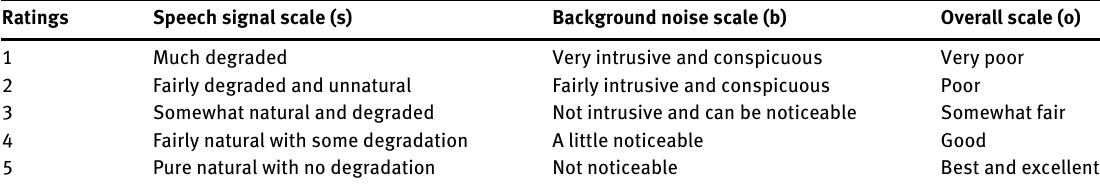
Table 1: The Description of the Speech Signal Distortion (s), Background Noise Distortion (b), and Overall Speech Quality (o) Scales